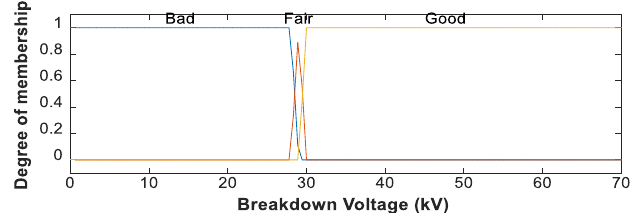
Figure 4. Membership functions for Breakdown voltage.